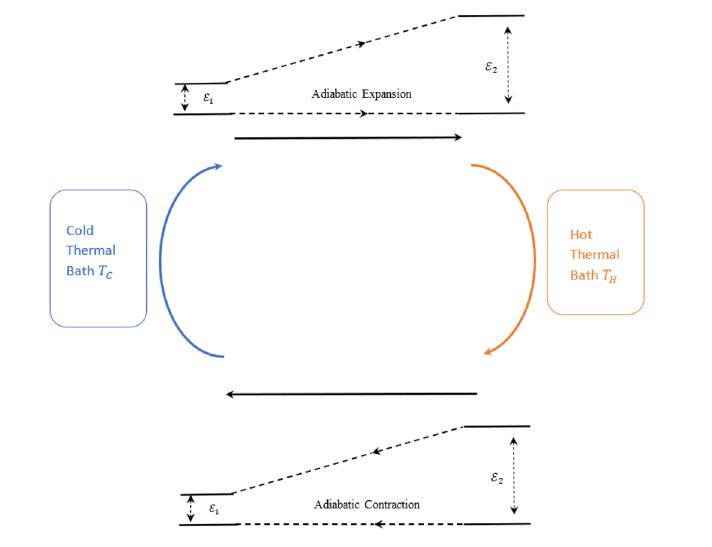
Figure 1. Thermodynamic cycle of Quantum Otto